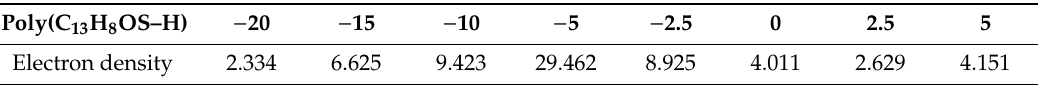
Table 1. The electron density for materials poly(C 13 H 8 OS–H) at di ff erent energies in the valence bands. Poly(C 13 H 8 OS–H) − 20 − 15 − 10